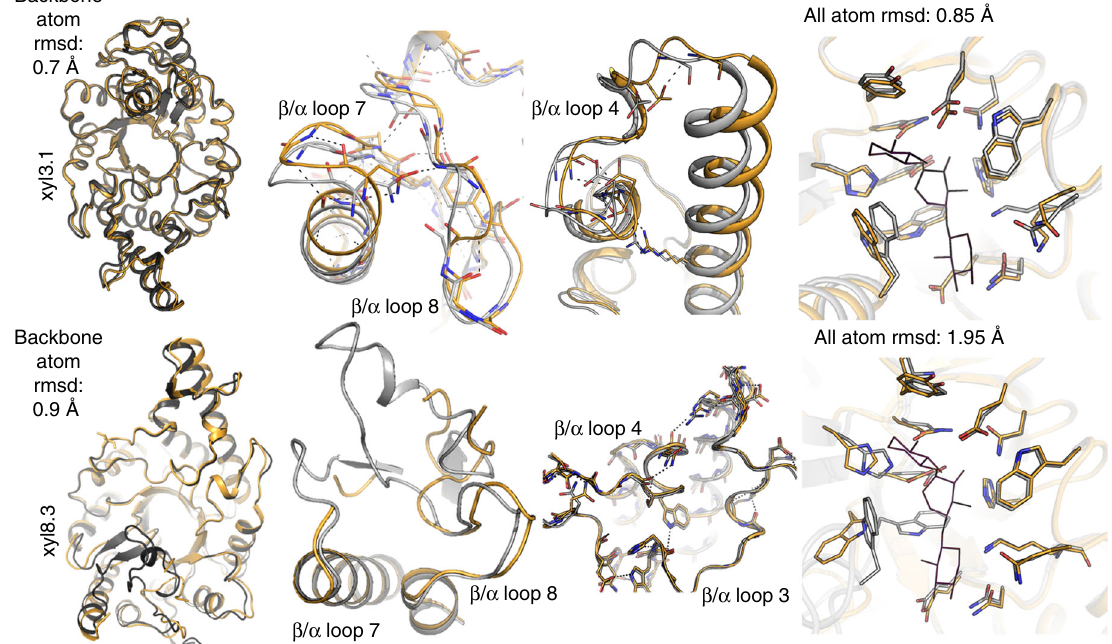
Fig. 4 Design models vs. experimental structures. Shown are design models (gray) and crystal structures (gold) of high and low ef fi ciency GH10 designs (xyl3.1 and xyl8.3, respectively). The designs were crystallized without substrate, and the coordinates of the substrate xylopentaose were extracted from PDB ID 4PUD (thin lines, right-hand side panels) after superimposing the designs ’ structures. The experimental structure of the high-activity design xyl3.1 is very similar to the design model throughout the backbone, as exempli fi ed in the formation of long-range interactions between β - α loops 7 and 8 and within β - α segment 4 and in the orientations of all active-site residues. The experimental structure of the low-activity design xyl8.3 is similar to the model in most segments, for instance, β - α segments 3 and 4, and the two catalytic Glu residues, but loops in segments 7 and 8 failed to show substantial electron